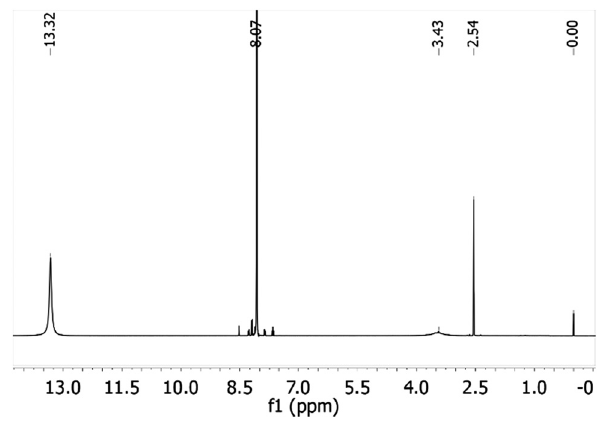
Figure 8: UV/Vis - spectra of the obtained TA in DMF ( 50 g/L ) solution at a wavelength of 330 – 350 nm.